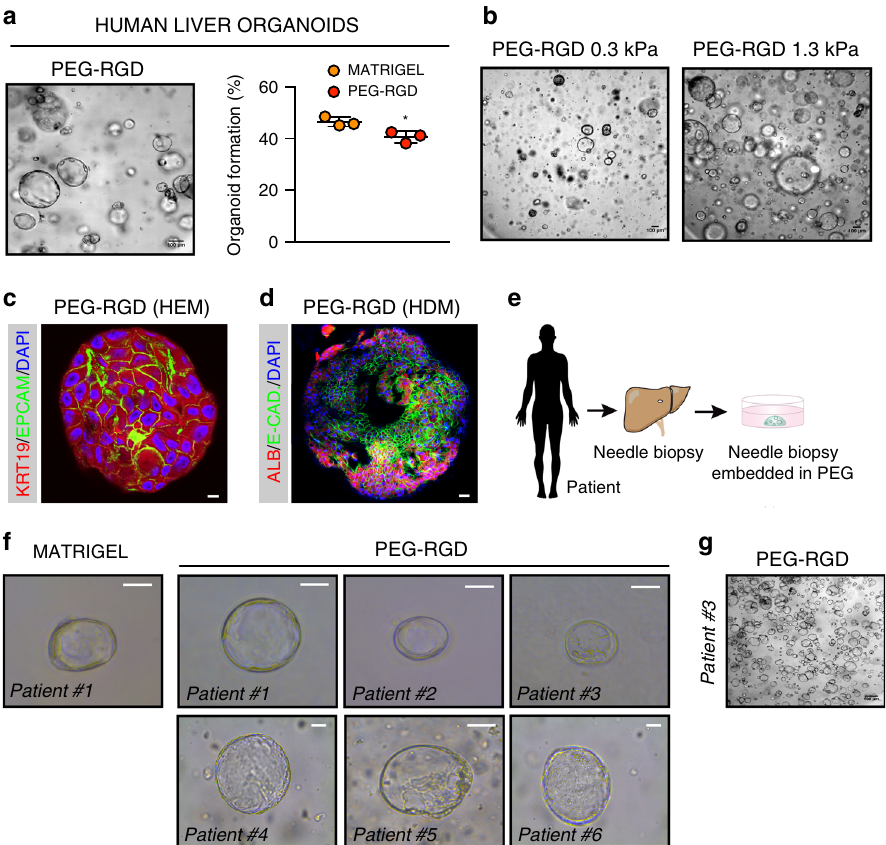
Fig. 5 PEG-RGD hydrogels allow for establishment, expansion and differentiation of patient-derived human liver organoids. a Matrigel-derived human liver progenitor cells were embedded in physiologically stiff PEG-RGD hydrogels and passaged in human expansion medium (HEM) with an ef fi ciency comparable to Matrigel. Representative picture (left) and quanti fi cation of organoid formation ef fi ciency (right). Graphs show individual data points derived from n = 3 independent experiments and means ± SEM, unpaired Student ’ s two-tailed t -test. * P < 0.05 ( P = 0.0231). b Effect of matrix stiffness on human liver organoid formation. c Representative confocal immuno fl uorescence image of KRT19 and Epcam in liver organoids embedded in physiologically stiff PEG-RGD hydrogels and cultured in HEM. Scale bar 10 μ m. d Representative confocal immuno fl uorescence image of Albumin and E-Cadherin in liver organoids cultured in human differentiation medium (HDM), Scale bar 25 μ m. e , f Freshly isolated liver biopsies from six patients were digested and directly embedded in PEG-RGD hydrogels. Scale bar 50 μ m. g PEG-RGD-derived human liver progenitor cells were embedded in physiologically stiff hydrogels and passaged in human expansion medium (HEM). Scale bar 100 μ m. Micrographs ( c , d , g ) are representative of three independent experiments. Source data are provided as a Source Data fi